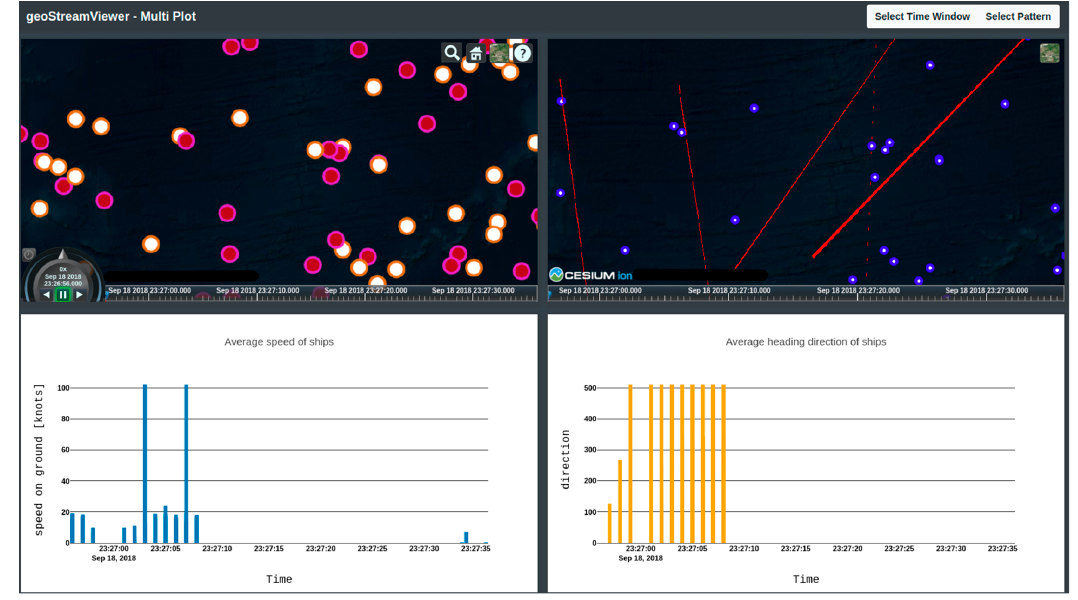
Figure 9. Behavior of a moving boat over a period of time.